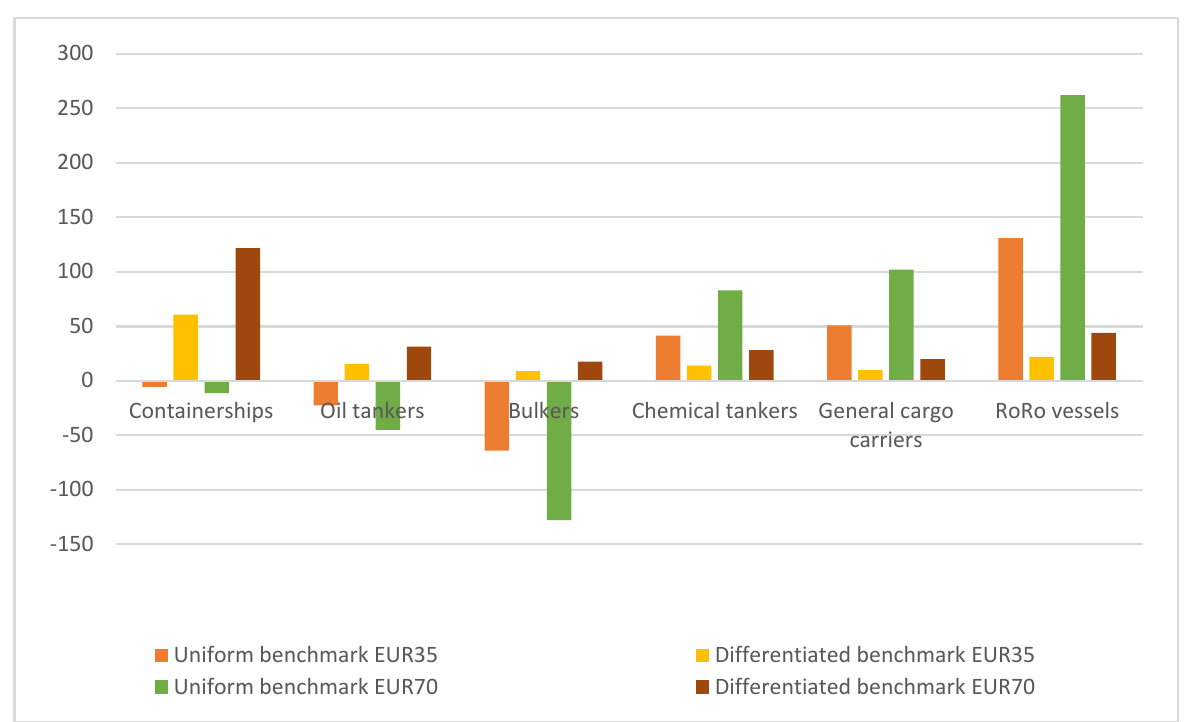
Figure 8. Cost increase per maritime segment assuming a uniform/differentiated benchmark and the inclusion of only internal EU voyages, expressed in MEUR. Source : Created by the authors.